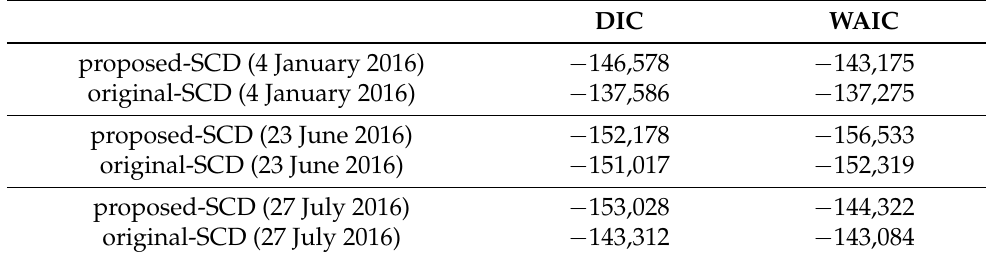
Table 29. Comparison of information criteria (TMC, Aichi, Japan).